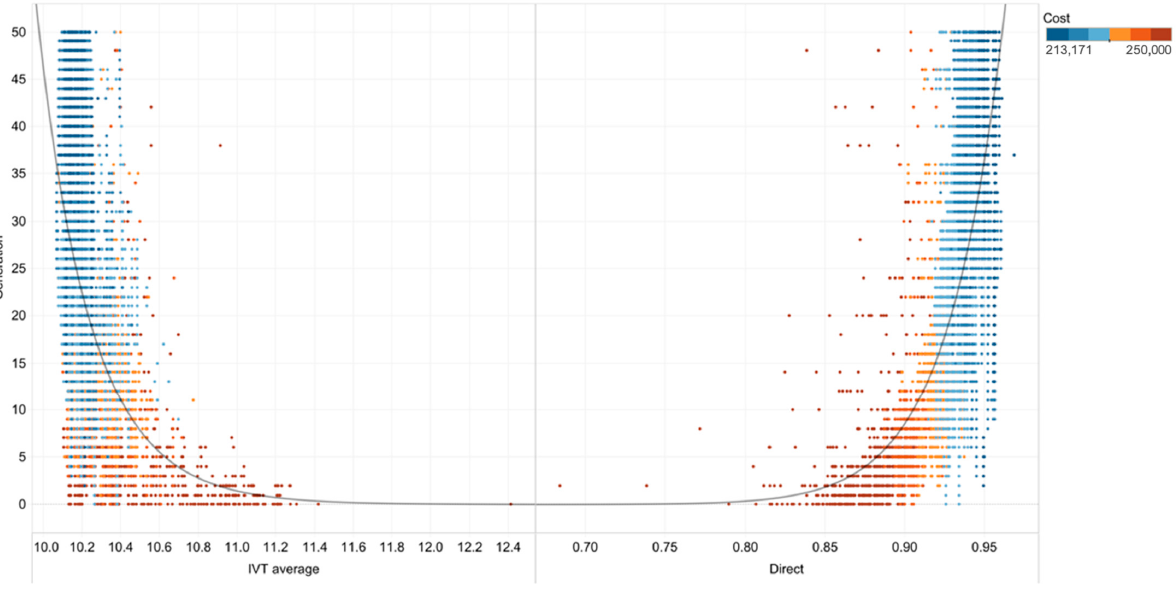
Figure 9. In-vehicle time and direct percentage optimization (color is user cost).